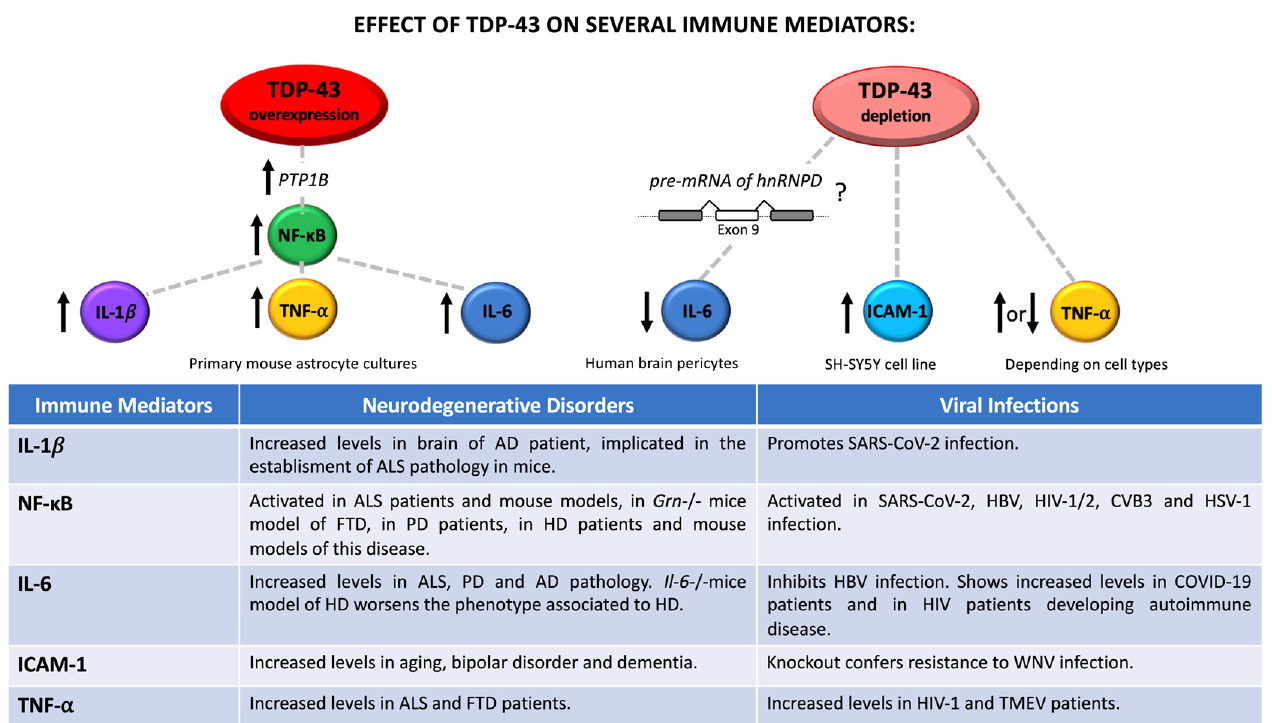
Figure 1. Relationship between TDP-43-controlled immune mediators and neuronal dysfunctions/viral infection. Regulation of TDP-43 levels contributes to increase or reduce the expression of different immune mediators, such as IL-1 β , NF- κ B, IL-6, ICAM-1, and TNF- α . Up- and downregulated effects are indicated with upward and downward arrows, respectively. Neurodegenerative and viral implications are also reported in the table.